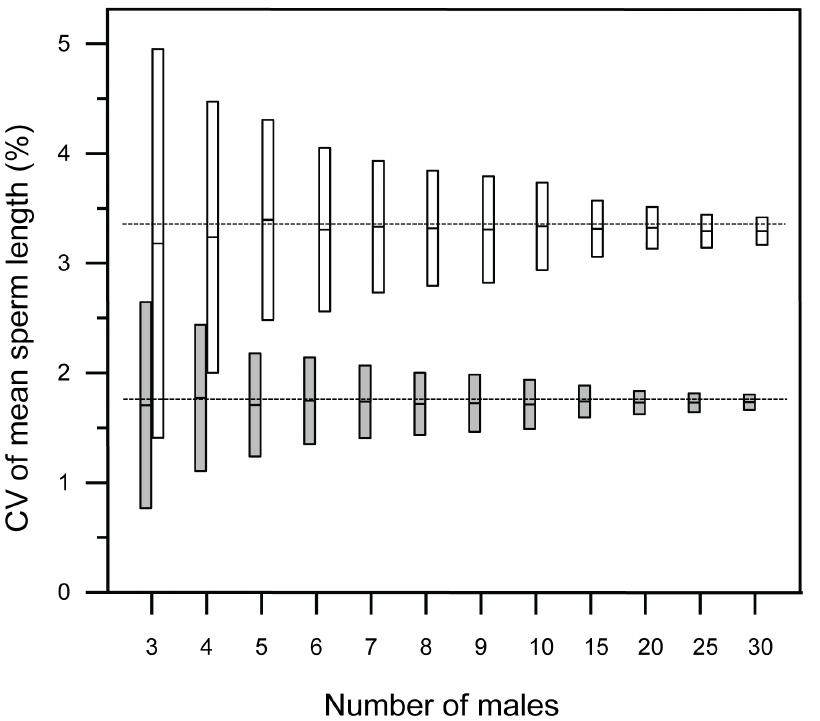
Figure 3. The effect of sample size on the coefficient of variation in male sperm length. The figure shows how the spread of calculated CV bm values (the coefficient of variation in mean sperm length) changes as a function of the number of males sampled. A resampling procedure was performed on two data sets; one from 35 male common redstarts Phoenicurus phoenicurus (open boxes) and one from 46 male tree swallows Tachycineta bicolor (grey boxes). CV bm was calculated from 1000 random samples (with replacement) for each sample size of 3 to 30 males. Boxes indicate 95% confidence intervals of the mean. Stippled lines mark the CV bm values calculated for all males in the two samples.